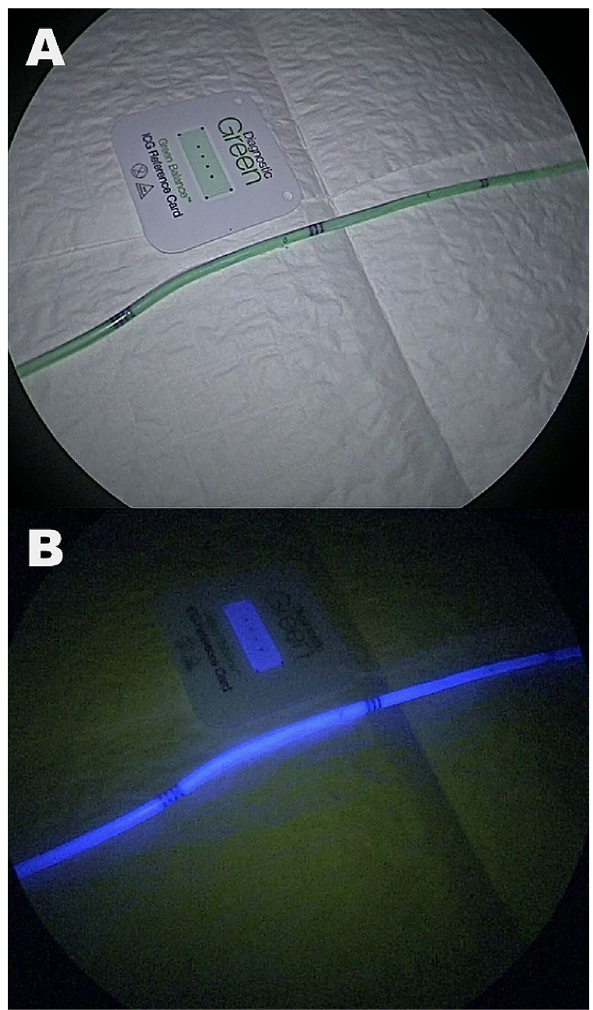
Figure 1. NICE-coated catheter demonstration under white light ( A ) and near-infrared light ( B